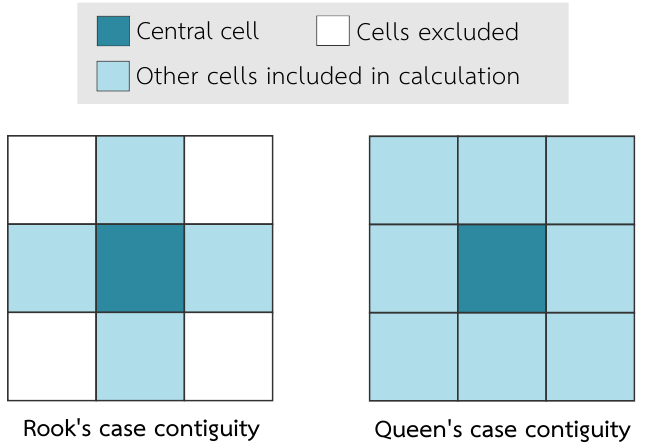
Figure 3. Rook’s case contiguity and queen’s case contiguity. Source: Reference